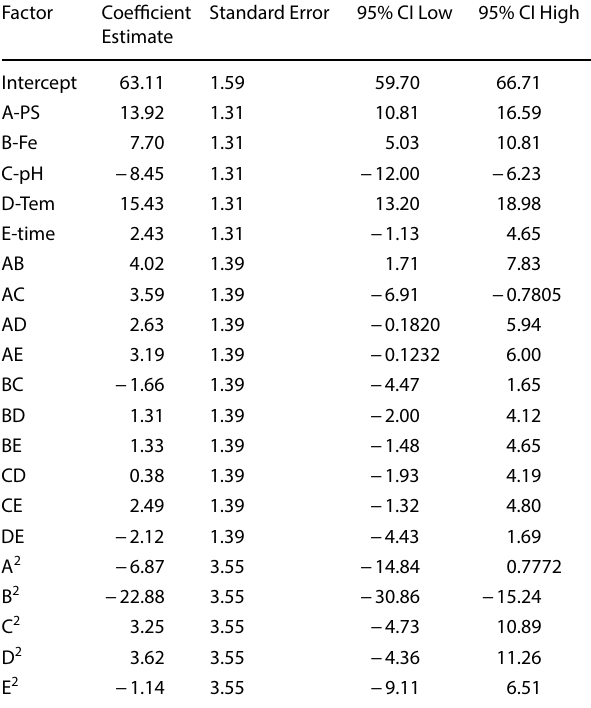
Table 5 Coefficients in terms of coded